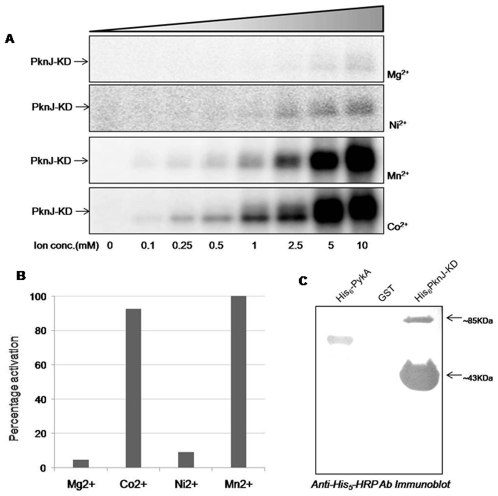
Regulation of PknJ-KD by metals-ions and dimer formation.(A) 1 µg PknJ-KD was incubated with increasing concentrations (0–10 mM) of different metal ions, individually in in vitro kinase assays. (B) Comparative analysis of PknJ-KD activation by MgCl2, MnCl2, CoCl2 and NiCl2 (10 mM each). Quantification of PhosphorImager units was done using ImageGauge software (Fujifilm) and converted to percentage activation. (C) To show PknJ-KD dimerization by immunoblotting, excess of PknJ-KD was resolved on 10% SDS-PAGE, transferred onto nitrocellulose membrane and probed with anti-His5HRP-conjugated antibody. His6-PykA and GST were taken as positive and negative controls, respectively.